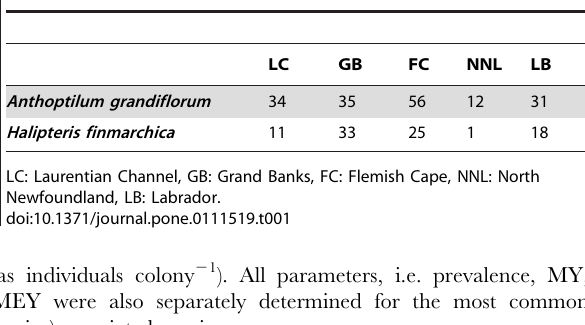
Table 1. Number of colonies sampled in the different geographic